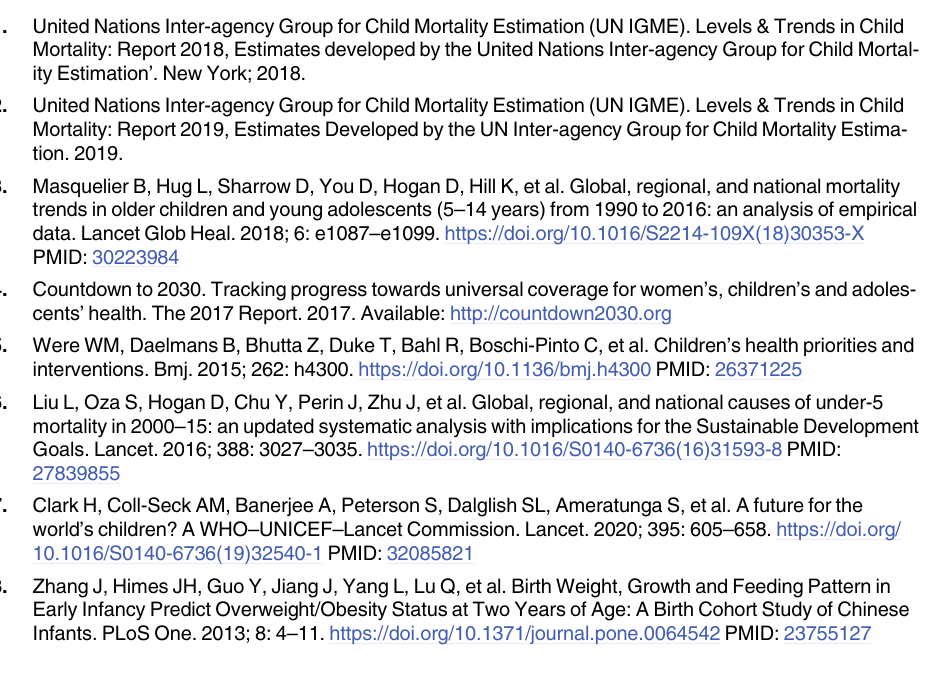
S2 Table. Determinants of birth weight, wealth and marital status missingness in birth reg- istration